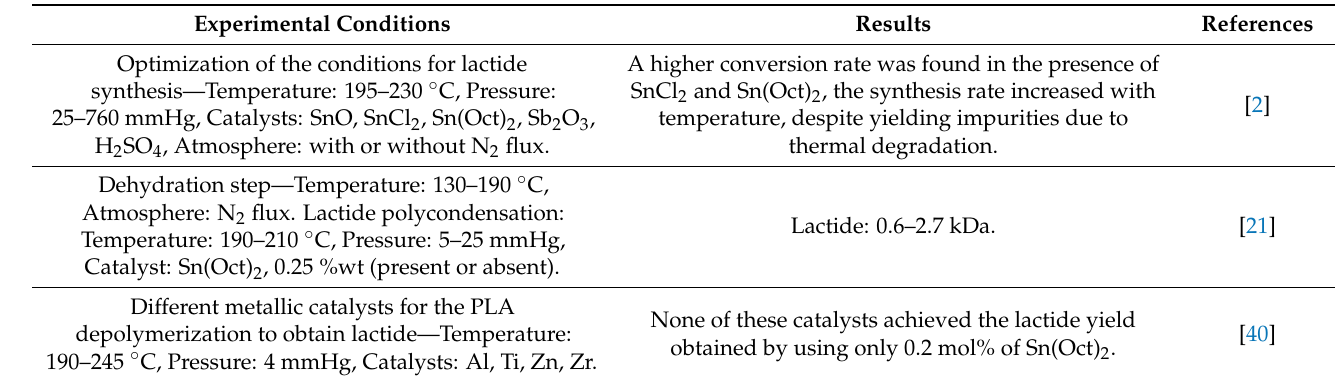
Table 3. Chemical processes for lactide